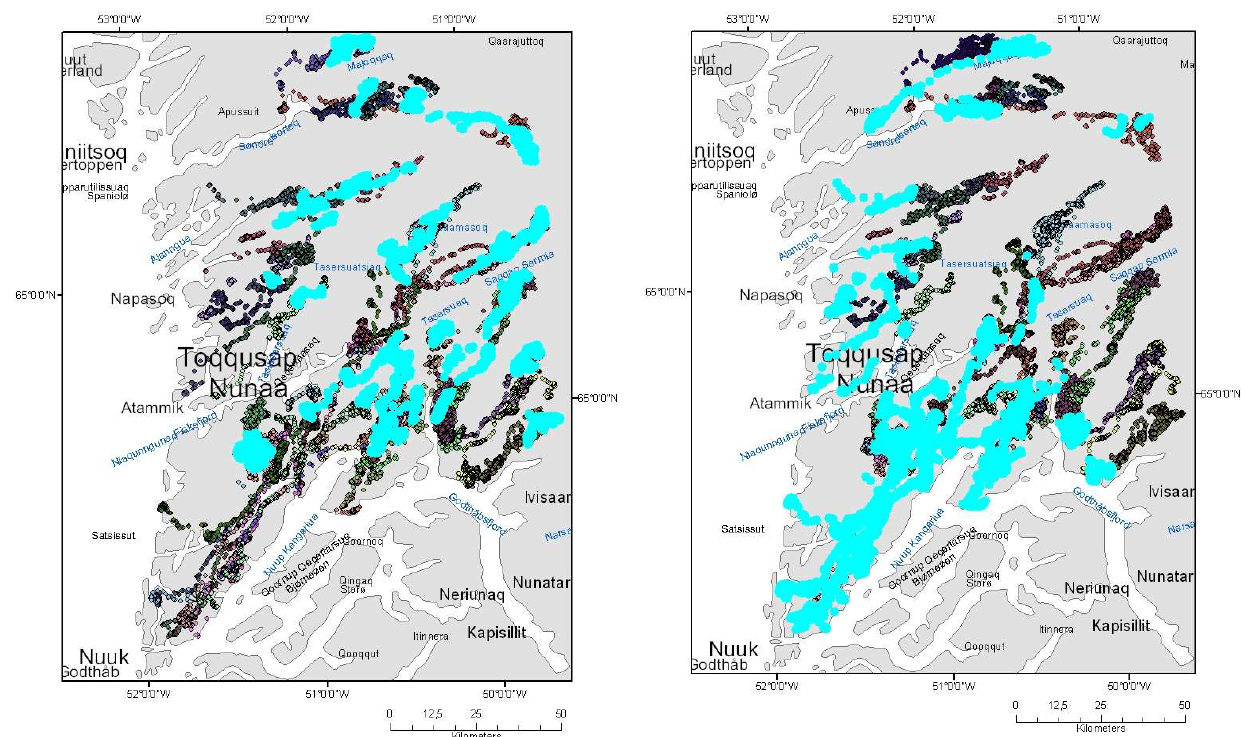
Fig. 1. Summary of caribou positions (highlighted with cyan) during calving May 25 to June 25 to the left. To the right caribou positions (highlighted with cyan) in autumn/early winter October 2008. The figure also shows all other locations to illustrate all movements during the study